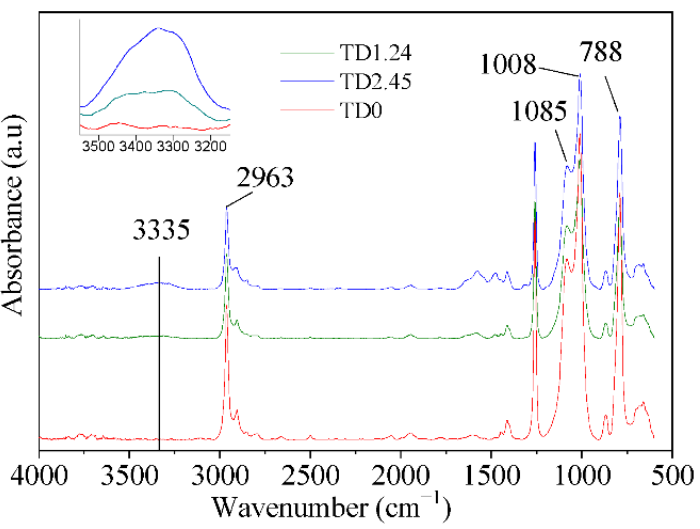
Figure 3. Infrared spectra of the typical silicone tie-coating samples. TD0 refers to the tie-coating sample without DAMO, TD1.24 refers to the tie-coating sample with DAMO of 1.24 wt.%, TD2.45 refers to the tie-coating sample with DAMO of 2.45 wt.%.